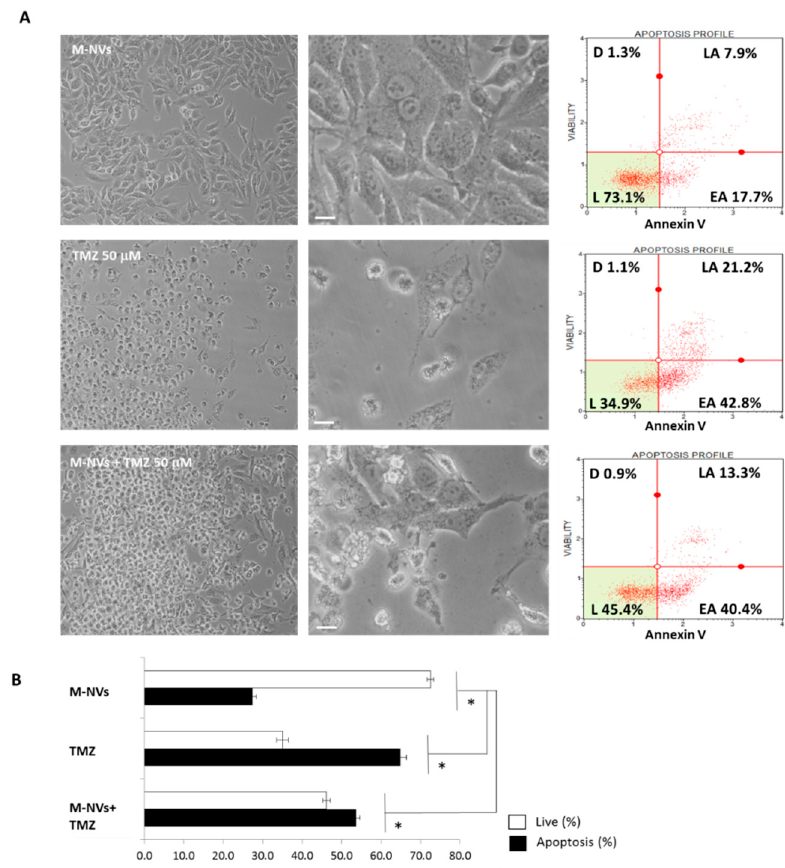
Figure 9. Cytofluorimetric viability assays in three different human astrocytoma cell lines (i.e., T98G, U138-MG and Res259) at 24 h after direct administration of mock plasma membranes generated vesicles (MVs), Temozolomide (TMZ) or Givinostat (GVS) and M-NVs loaded with TMZ or GVS separately (each 50 μ M). Experiments were in triplicates analyzing 5000 cells for each treatment and asterisks indicate p < 0.05, Anova One-way compared to mock samples.